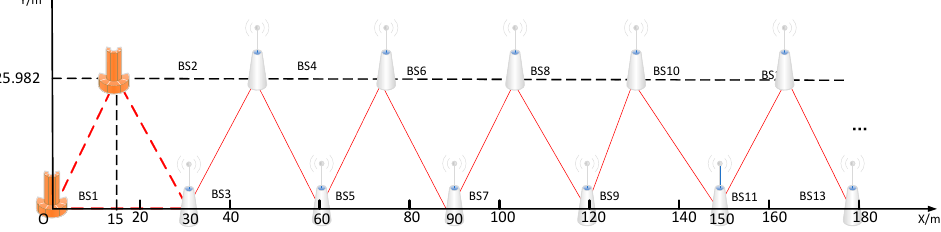
Figure 12. Coordinate system for our semi-autonomous configuration technology.